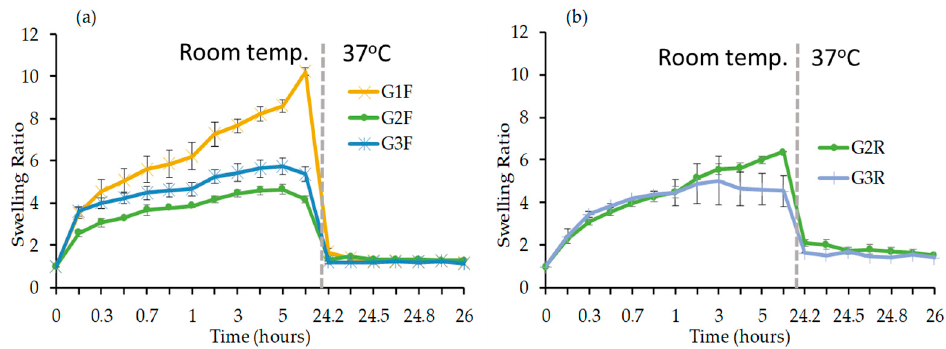
Figure 3. Evolution of the swelling ratio (SR) as a function of time in deionized water at room temperature for 24 h and then at 37 °C (shown as a grey line) for another 4 h for PNIPAAm gels prepared using ( a ) free radical polymerization (FRP) and ( b ) RAFT polymerization.